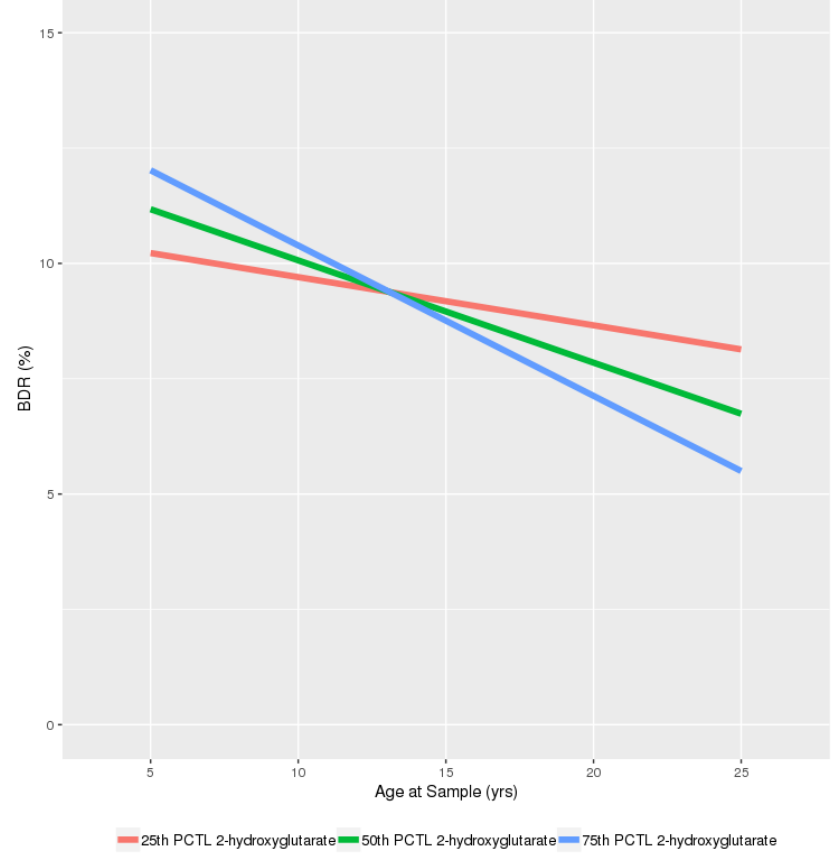
Figure 1. Predicted relationship between Age and BDR stratified by plasma levels of 2-hydroxyglutarate in CAMP (25th, 50th and 75th percentile). PCTL-Percentile; GABA— Gamma-Aminobutyric acid; CE—Cholesterol Ester